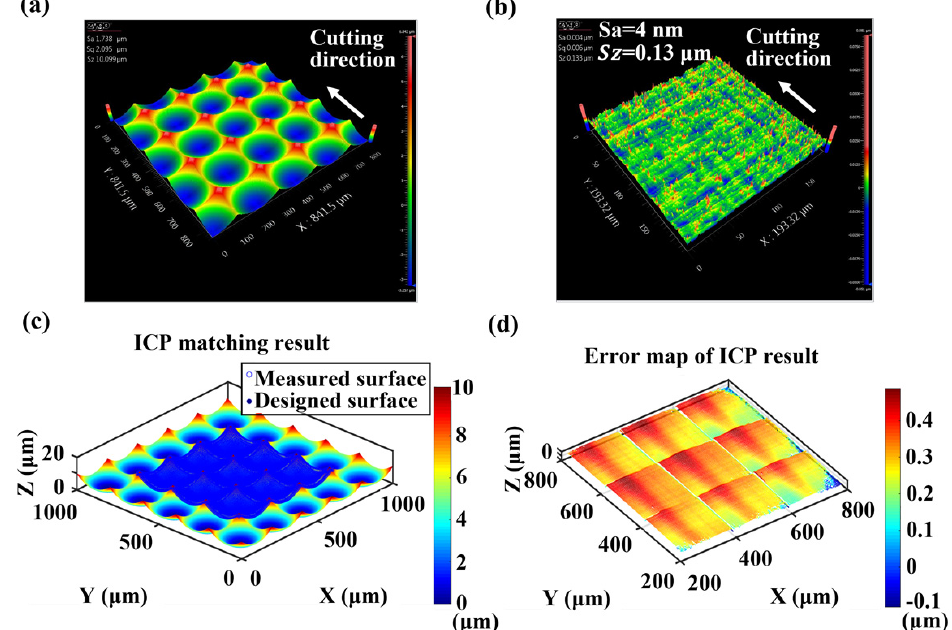
Figure 13. An analysis of surface quality and form accuracy of the microlens array machined by HFUVAS: ( a ) measured 3D structure, ( b ) surface morphology of a single lenslet after removing the 3D form, ( c ) ICP match result of the measured structure and the designed structure; ( d ) error map obtained from the ICP result.